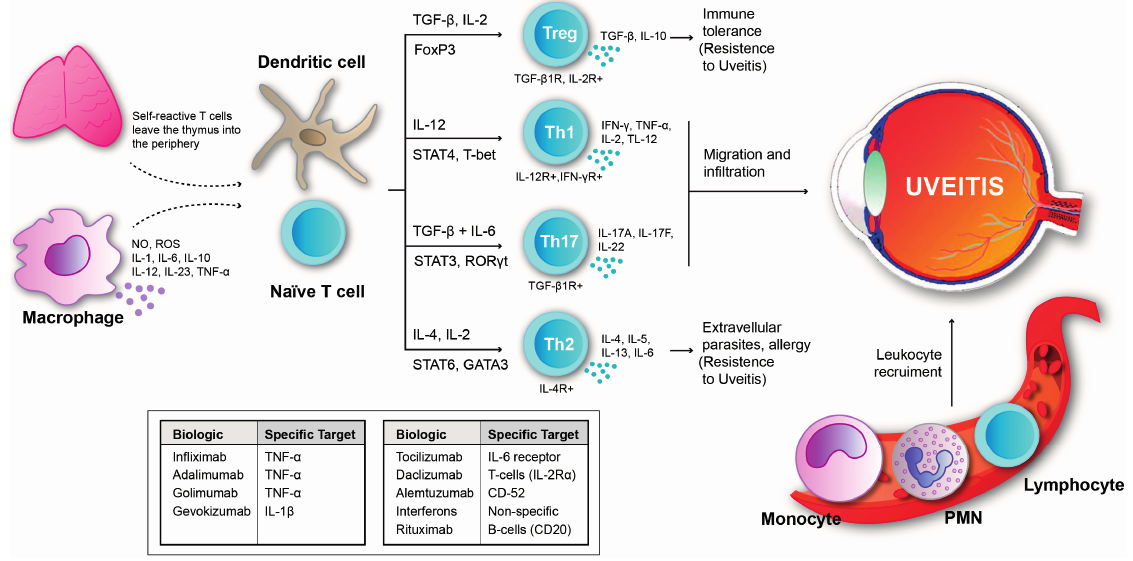
Figure 1. Uveitis results from imbalance between inflammatory mechanisms and regulatory mechanisms. Acute inflammation initiated by those cells that are previously present in affected tissues, mainly resident macrophages and dendritic cells [12]. In autoimmune uveitis, self-reactive T cells leave the thymus and when they reach the eye they come in contact with retinal antigens. Myeloid dendritic cells present a solid ability of capturing antigens, which enables them to stimulate T cells. Therefore, T-lymphocytes may differentiate into Tregs, Th1, Th17 or Th2 for precise immune response in function of the antigen encountered and cytokine presence. Th1 and Th17 cells participate in inflammatory and autoimmune uveitis. Th1 cells are crucial for the development of uveitis, whereas Th17 cells play a relevant role in the late/chronic phase of uveitis, however induced Treg cells defeat both Th1 and Th17 cell responses [13–17]. Furthermore, the migration of Th1 and Th 17 to the eye, also results in the breaking down of the blood-retinal barrier and, consequently, different leukocytes from the circulation are recruited. In the figure, we can also see the main biologics that are being presently used in uveitis therapy and its